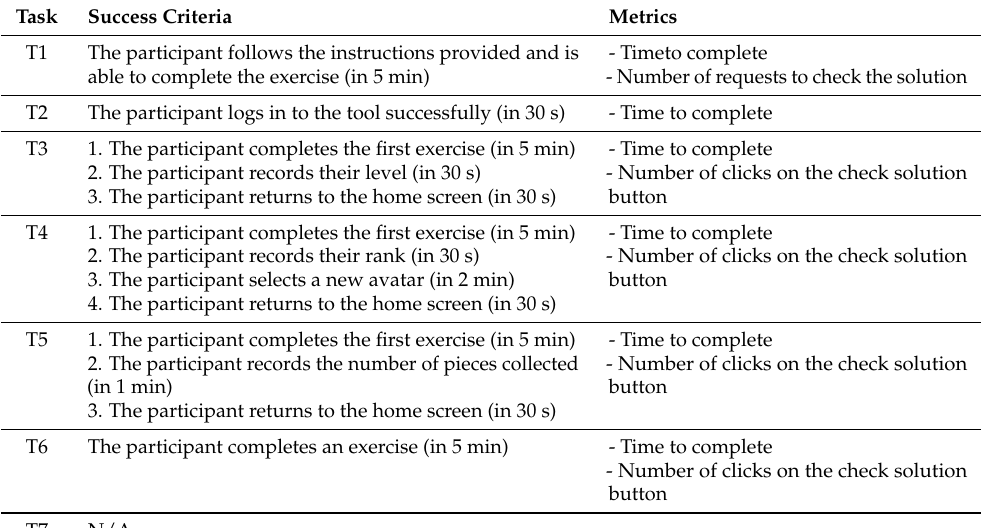
Table 4. Usability task success criteria.